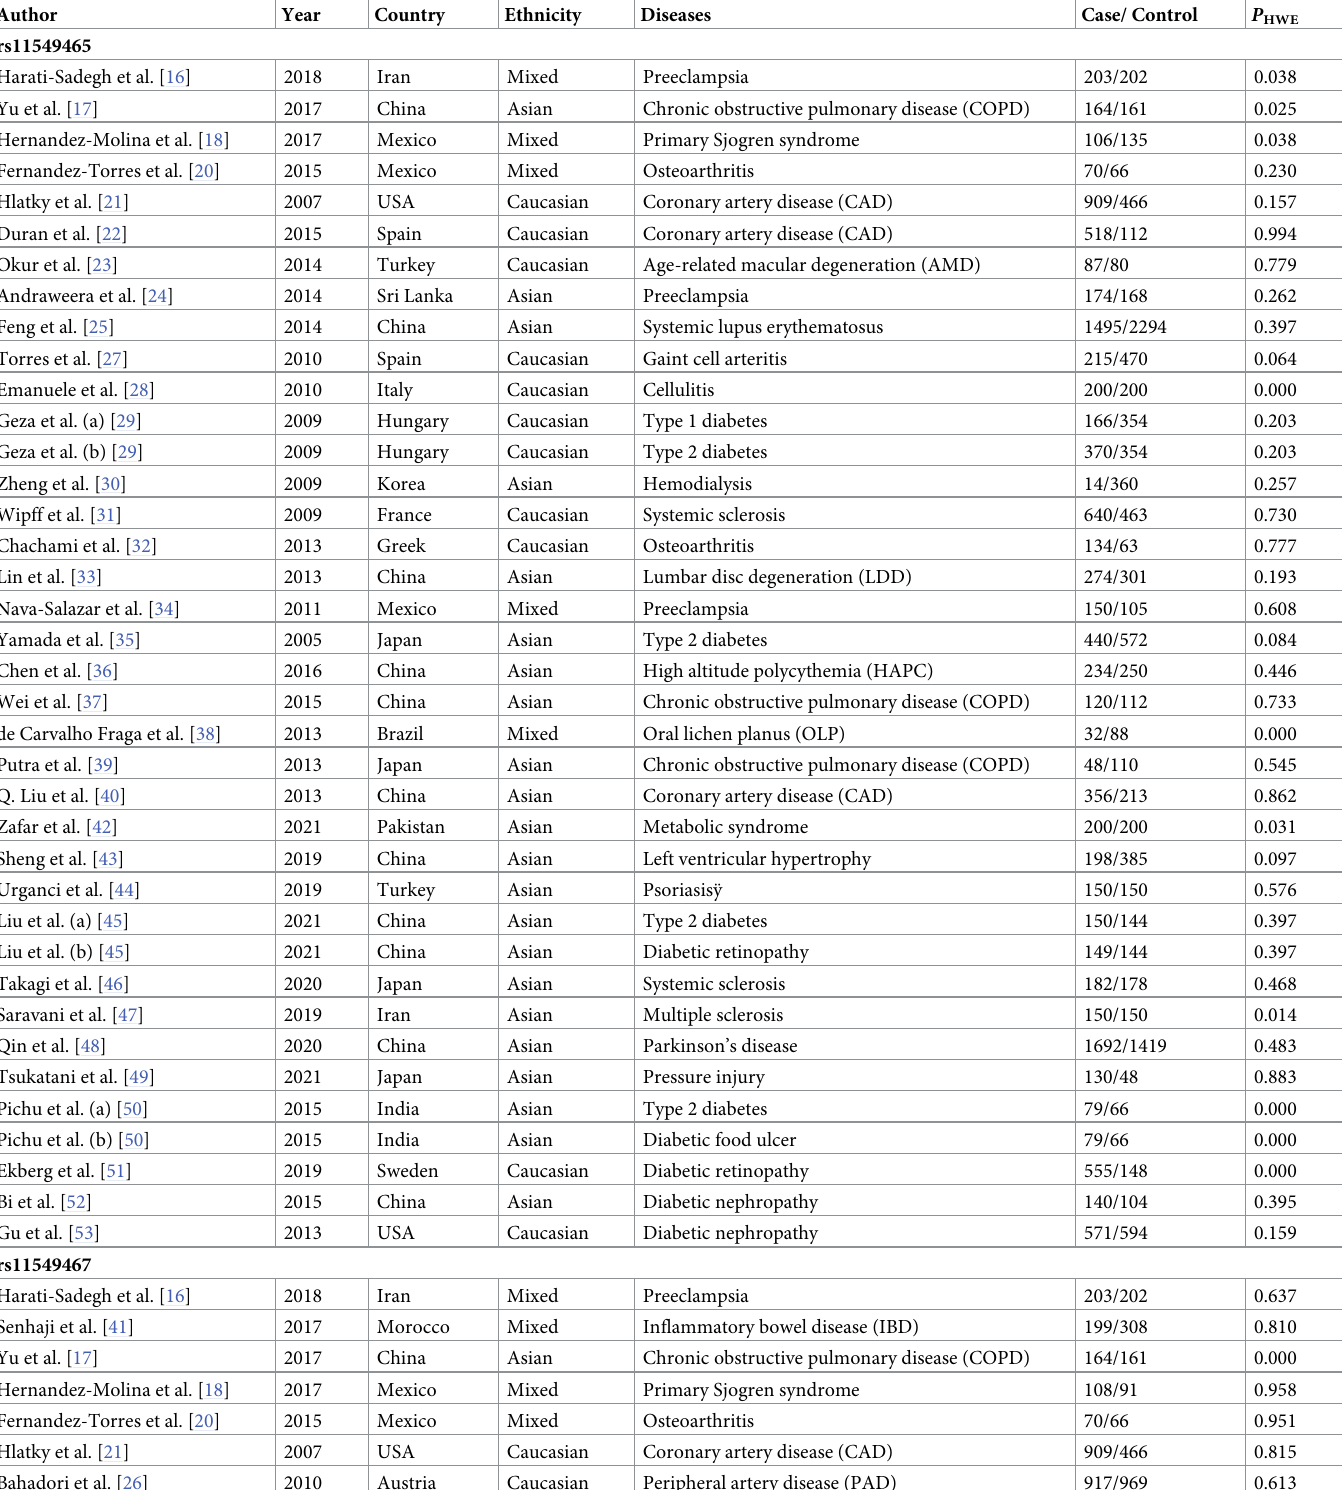
Table 1. Characteristic of 38 and 24 studies included in the meta-analysis of HIF1A 1772 C/T and 1790 G/A polymorphisms,